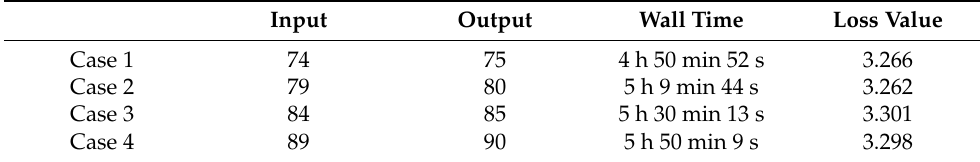
Table 8. Comparison of learning models according to the size of the sliding